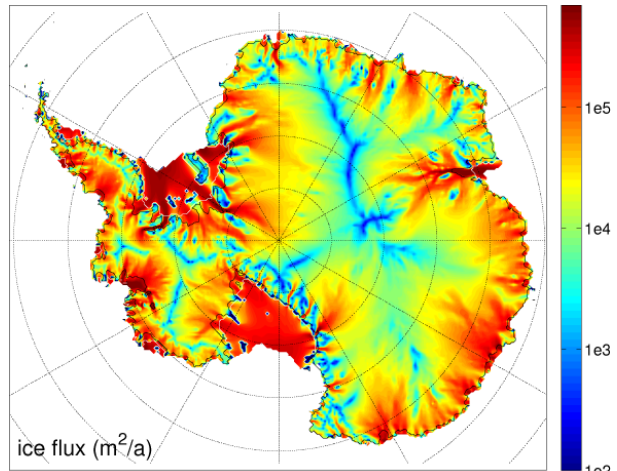
Fig. 11. Modeled vertically-integrated horizontal ice flux. Ice streams are outlined in black, grounding line position in